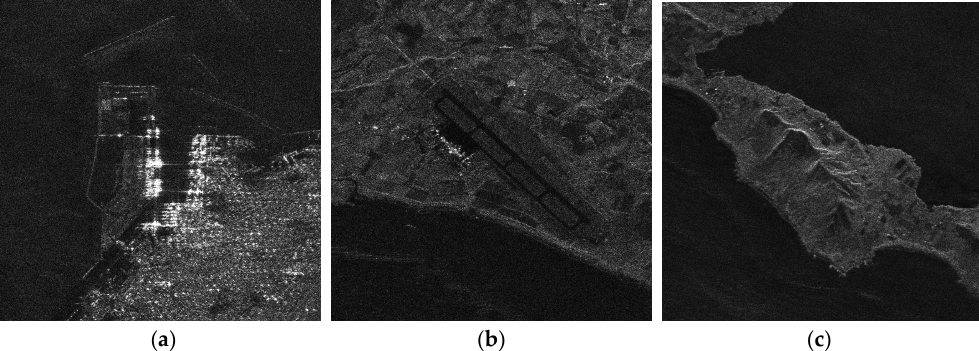
Figure 20. The enlarged view of the three areas in the RD algorithm result when the azimuth fully sampled data. ( a ) Area A1. ( b ) Area A2. ( c ) Area A3.